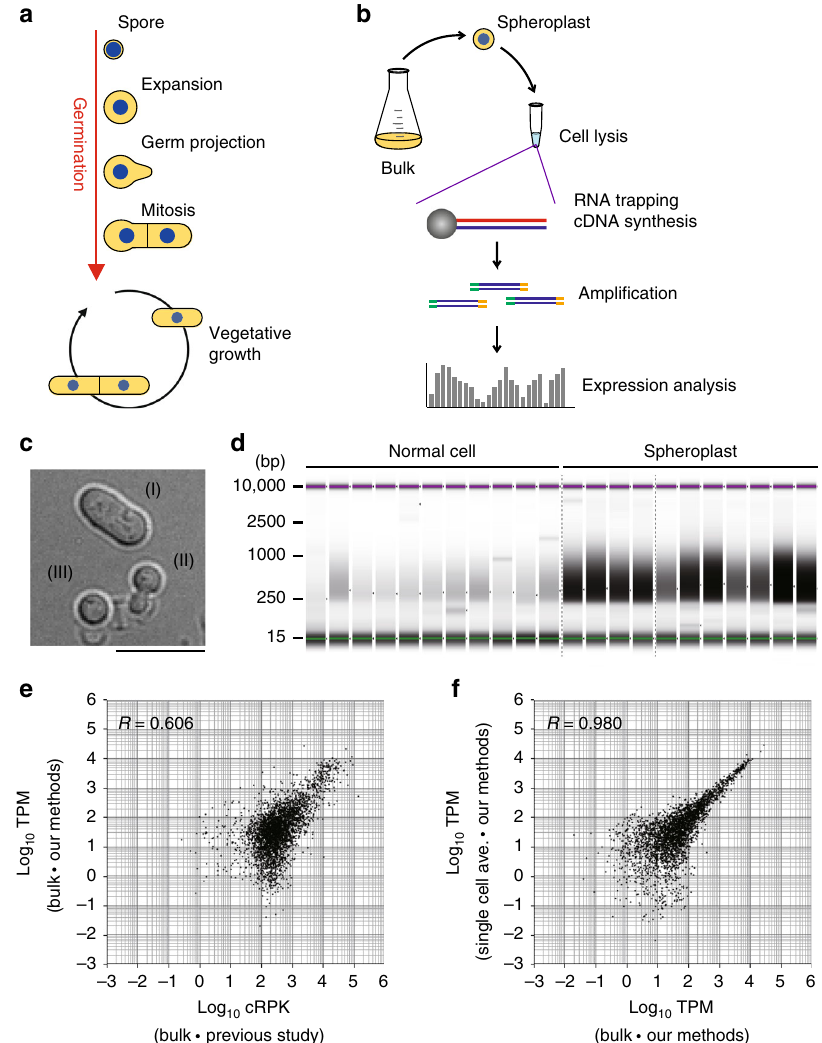
Fig. 1 Validation of single-cell transcriptome methods. a Germination processes and entry into vegetative growth of S. pombe cells. b Overview of the bead-based scRNA-seq developed in this study. c Differential interference-contrast images of WT cells after treatment with lysing enzyme: (I) cells not lysed, (II) cells being lysed, and (III) cells that were substantially lysed. Representative cells of >10 independent experiments are shown. Scale bar, 10 µ m. d Assessment of scRNA-seq library from 22 single cells for which spheroplasts were prepared or not prepared (Normal cell), as assessed with electrophoresis. Each lane corresponds to a sample from a single cell. Size (bp) is shown to the left. Data are representative of two independent experiments. Uncropped original image is shown in Supplementary Fig. 8. e Comparison of S. pombe transcriptomes created from bulk cells in this study and in a previous study 9 . f Comparison of single-cell-based transcriptomes (average of 11 cells) and transcriptomes created from bulk cells in this study. TPM transcripts per million mapped reads, cRPK reads per kilobase of length corrected for mappability. Source data are provided as a Source Data fi